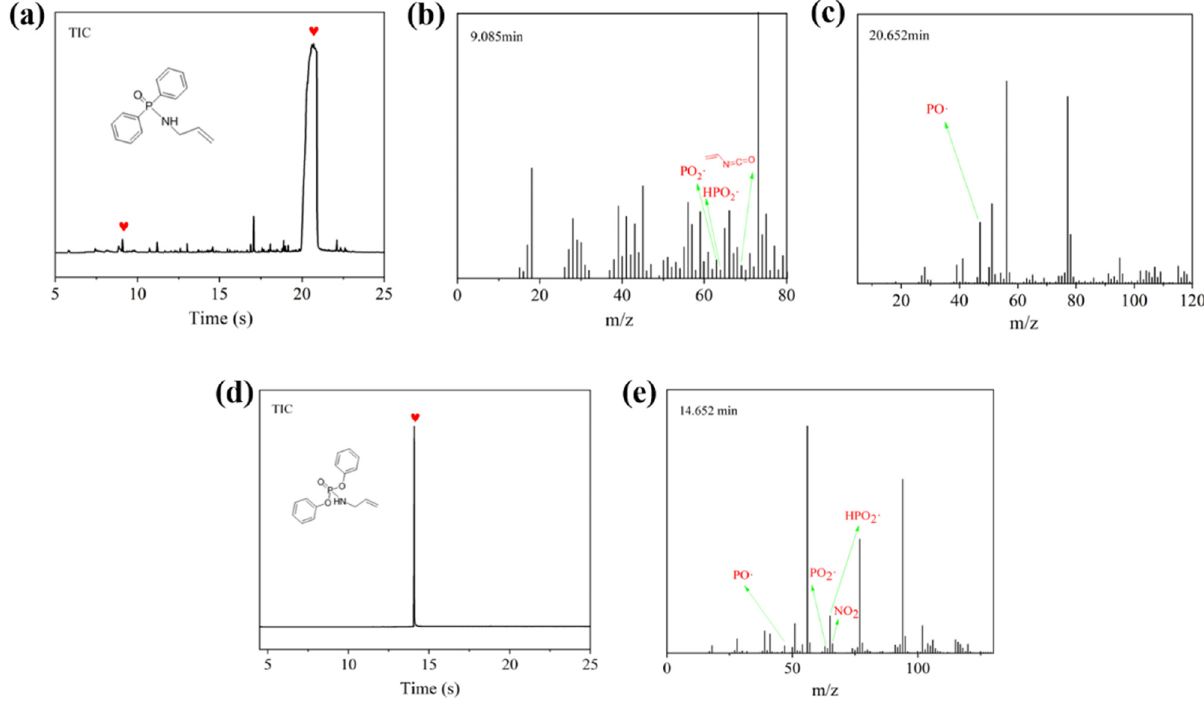
Figure 9: ( a, d ) Total ions chromatograph ( TIC ) and ( b, c, e ) Py - GC/MS spectra of main pyrolysis products of DPCA and